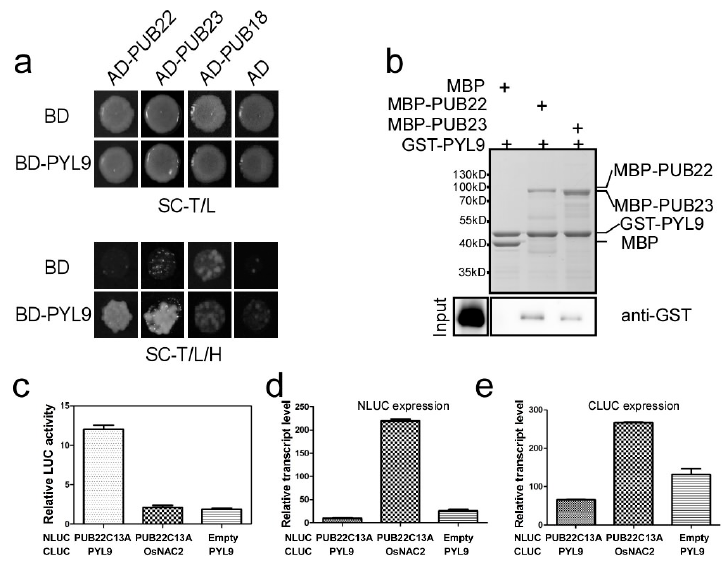
Figure 3. ABA receptor PYL9 interacts with two highly homologous plant U-box E3 ligases, PUB22 and PUB23. ( a ) PYL9 interacts with PUB22 and PUB23 in yeast two-hybrid assays. The growth of yeast transformed with the indicated constructs on selective plate is shown. Empty vectors (BD or AD) were used as negative controls. ( b ) PYL9 interacts with PUB22 and PUB23 in pull-down assays. Five micrograms MBP-PUB22, MBP-PUB23, or MBP bound with amylose resin were incubated with 1 μ g GST-PYL9 for one hour at room temperature. Five percent of the input proteins were run on the PAGE gel and visualized via coomassie brilliant blue staining (upper panel). After washing five times, the protein complex pulled down by resin was detected with anti-GST antibody (lower panel). ( c ) PYL9 interacts with PUB22C13A by firefly luciferase complementation imaging assay. The indicated combinations were co-transfected with the CaMV35S:GUS construct into tobacco leaves and incubated for five days. LUC activity was normalized with the GUS activity. Data are the means ± standard errors ( n = 3). ( d ) The transcript level of NLUC in the combinations in ( c ). Data are the means ± standard errors ( n = 3). ( e ) The transcript level of CLUC in the combinations in ( c ). Data are the means ± standard errors ( n = 3).